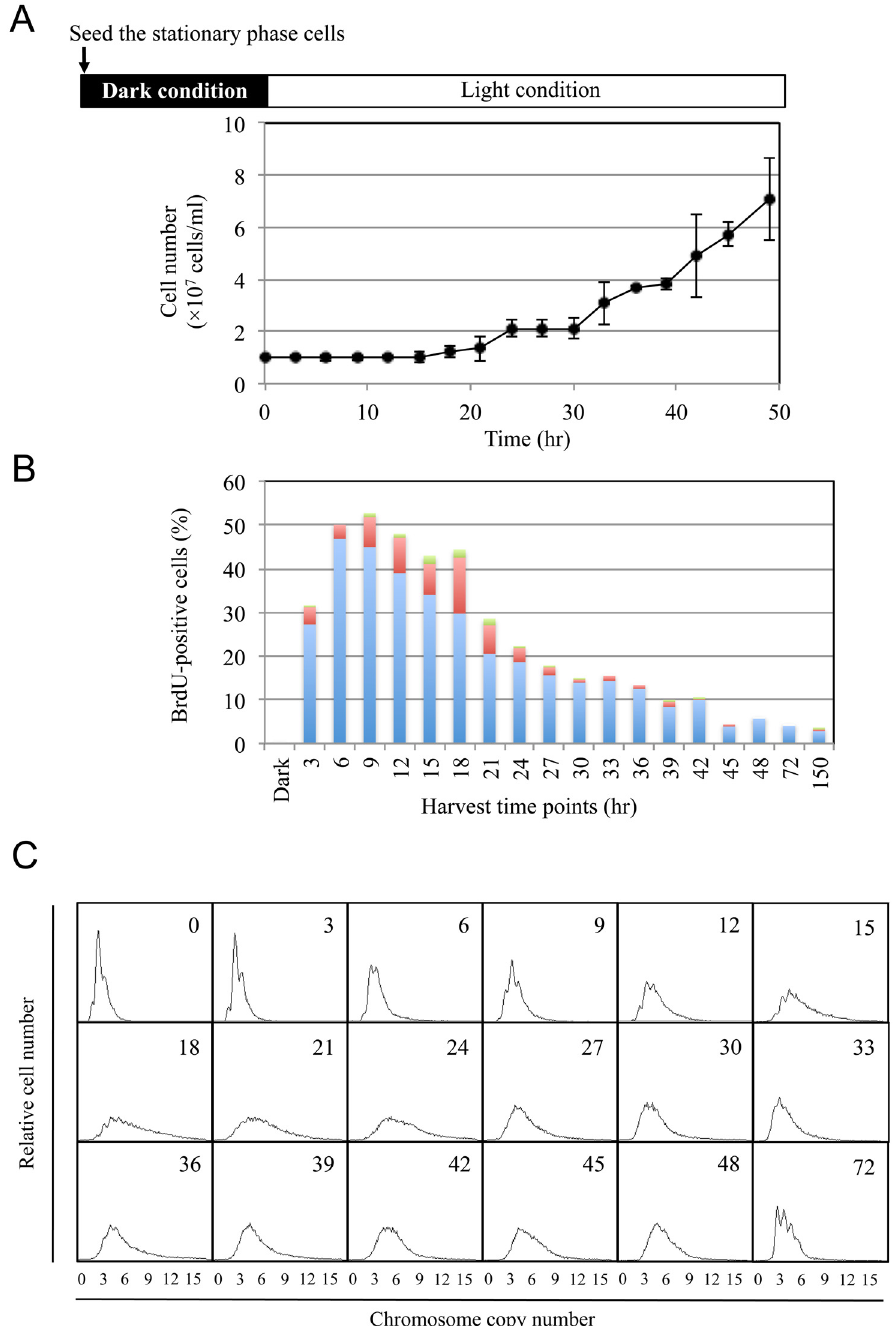
Fig 2. Cell doubling and chromosome copy number post-transfer. (A) Cell numbers post-transfer, which were calculated under a microscope using a bacteria counter (As One Co., Osaka, Japan). (B) The proportion of BrdU-positive cells after exposure to light. Synechococcus 7942 TK cells were labelled with BrdU for 30 min, harvested at the indicated times, stained with an anti-BrdU antibody, and examined with immunofluorescence microscopy. The proportion of BrdU-positive cells (BrdU-positive cells per 300 cells) is depicted using different colours, with each colour representing a different number of foci per cell: blue = 1 focus, red = 2 foci, green = 3 or more foci per cell. (C) DNA content profiles of Synechococcus 7942 TK cells. Cells were harvested at each time point and analysed with flow cytometry.